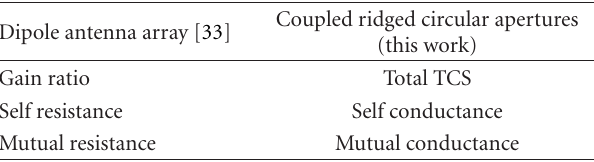
Table 5: Duality between half-wavelength dipole antenna array and ridged circular